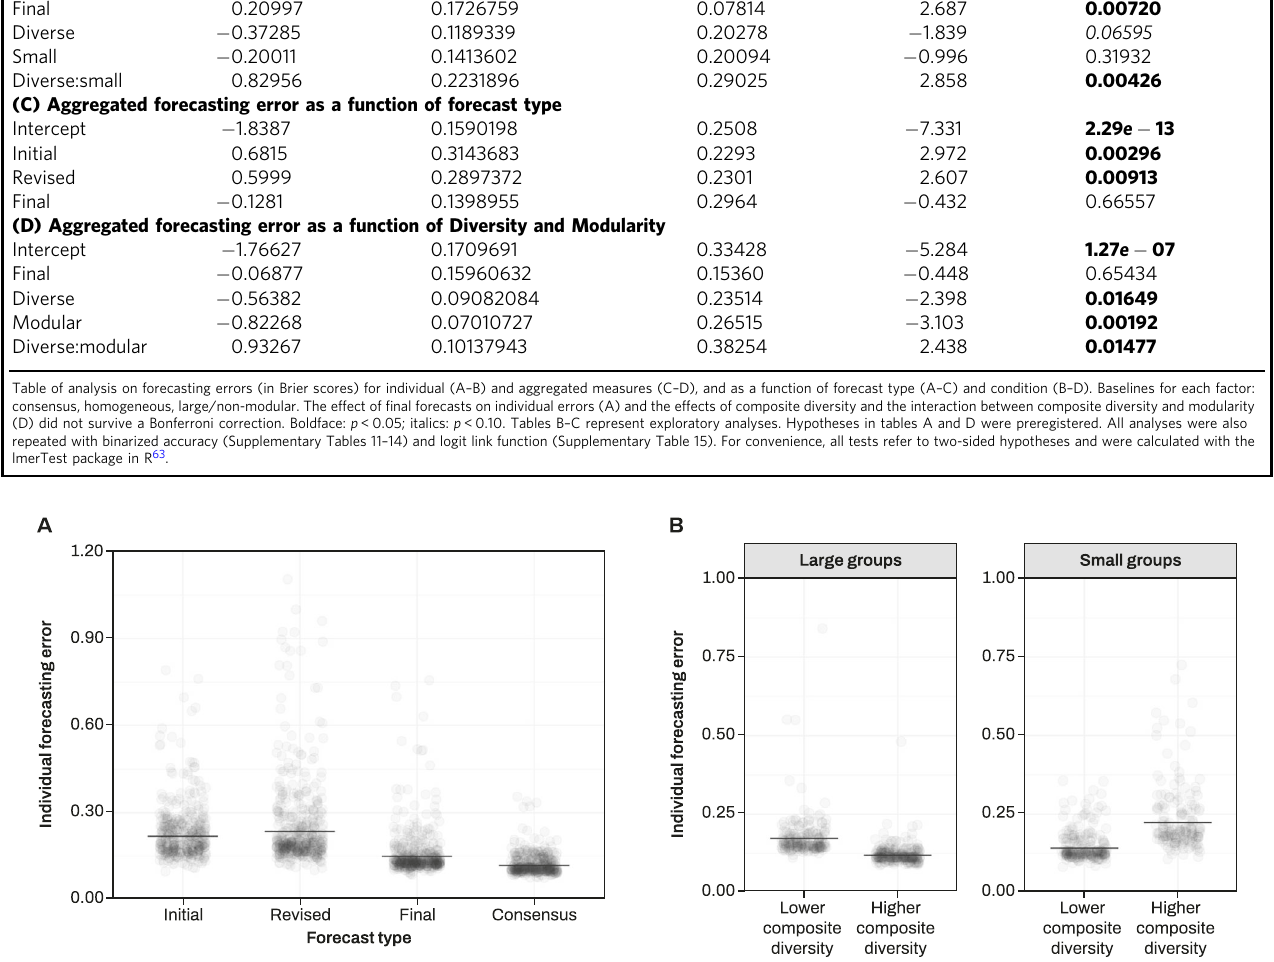
Fig. 2 Individual-level analysis. A Partial residuals plot showing the effect of forecasting type on individual forecasting error (measured in Brier scores). Lower numbers represent higher accuracy. Solid lines represent model fi t. B Partial residuals plot showing the effect of diversity and group size on individual forecasting error (expressed in Brier scores). Solid lines represent model fi t. Notice that, for visualization purposes, the graphs have been plotted onto the original error scale rather than log scale as in the fi tted GLMM. Thus, large residuals should not cause concern 64 . See Supplementary Fig. 10 when using a logit link. Source data are provided as a Source data fi